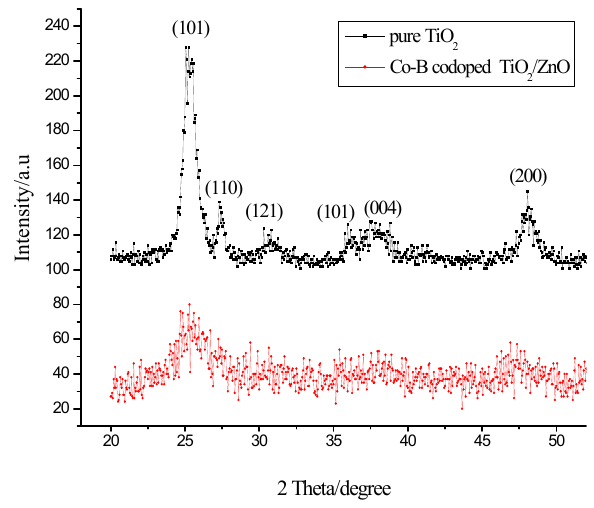
Figure 7. XRD patterns of pure TiO 2 and Co-B codoped TiO 2 /ZnO samples.